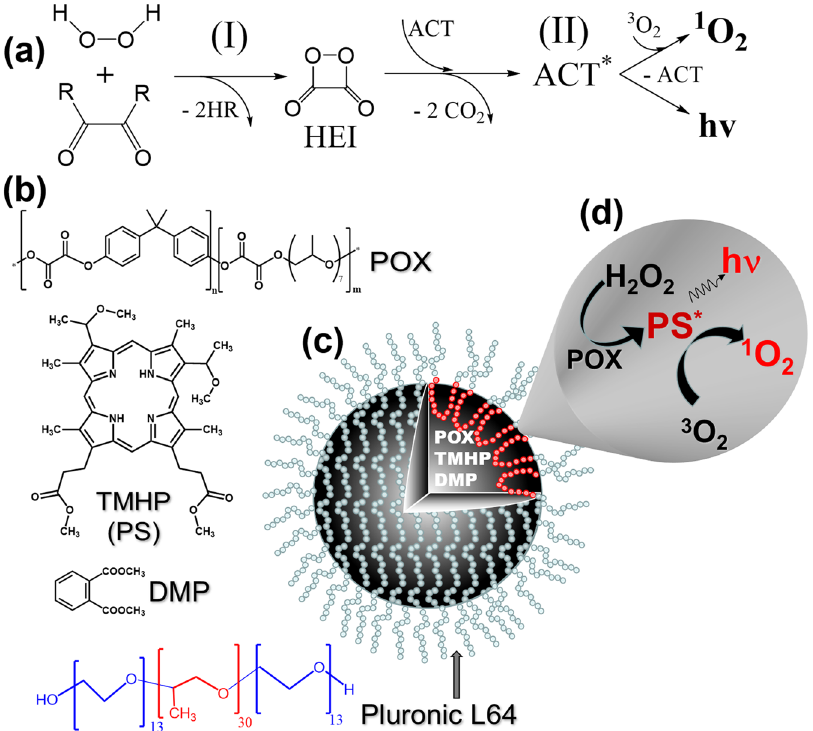
Figure 1. Scheme of the designed approach. ( a ) Scheme of peroxyoxalate chemiluminescent reaction. R – electron-withdrawing group. ( b ) Structures of Polyoxalate ( POX ), tetramethylhematoporphyrin IX ( TMHP ), dimethylphthalate ( DMP ), and Pluronic L64; ( c ) Sketch of the dispersion particles containing POX and TMHP in droplets of DMP stabilized with Pluronic L64; ( d ) PO-CL reaction with endogenous H 2 O 2 results in light emission and production of singlet oxygen capable to eliminate tumour